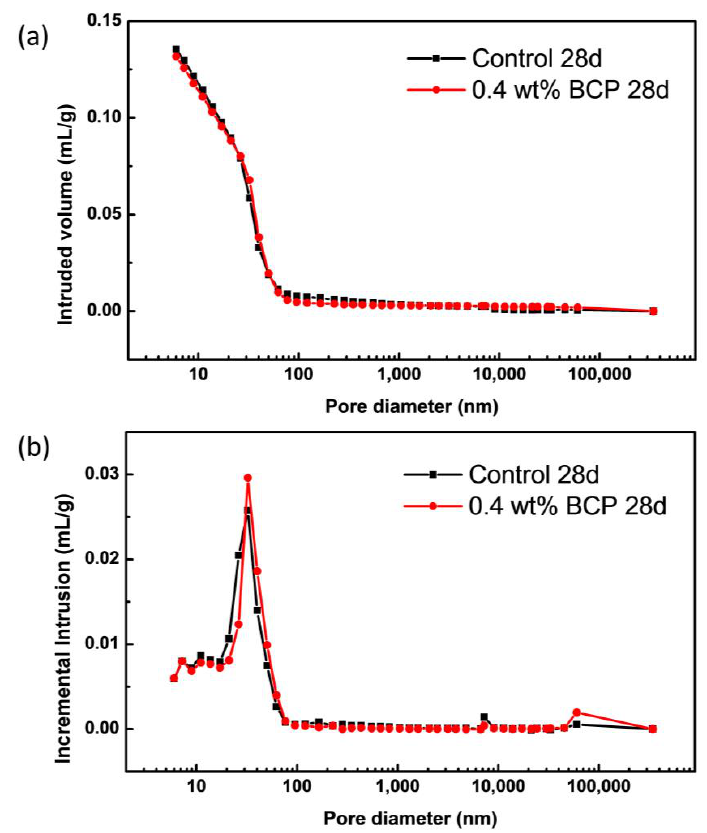
Figure 9. ( a ) Cumulative pore volume and ( b ) incremental pore volume of control and BCP doped cement pastes samples collected from mercury intrusion cement pastes samples collected from mercury intrusion porosimetry. Table 2. Basic parameters of pore structure estimated from MIP characterization.